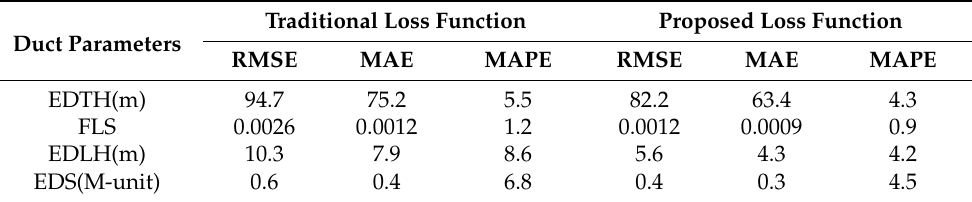
Table 4. Comparison of inversion results based on loss functions (white Gaussian noise). Traditional Loss Function Proposed Loss Function Duct Parameters RMSE MAE MAPE RMSE MAE MAPE EDTH(m) 94.7 75.2 5.5 82.2 63.4 4.3 FLS 0.0026 0.0012 1.2 0.0012 0.0009 0.9 EDLH(m)